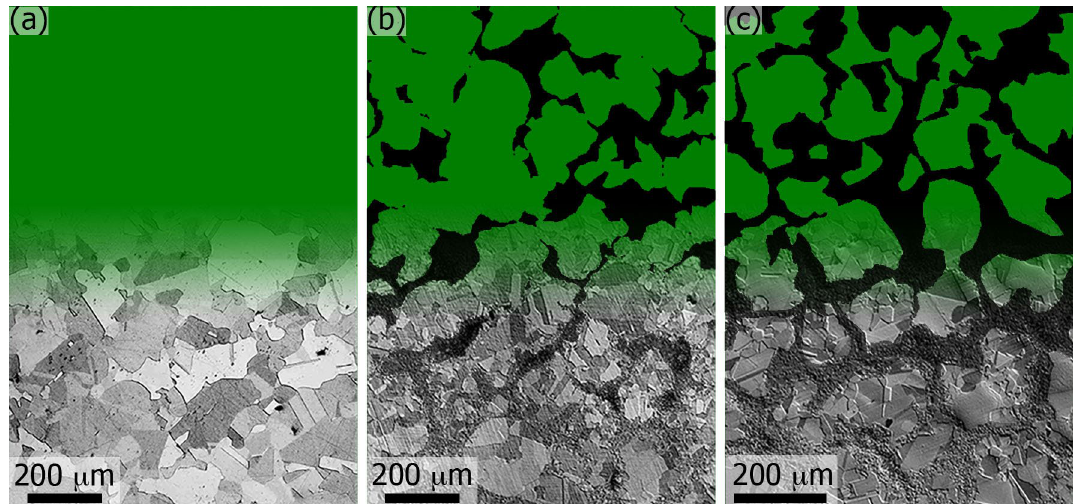
Figure 1. Representative optical micrographs of pure nickel with homogeneous CG ( a ) and heterogeneous bimodal random bR ( b ) and harmonic bHS (c) grain structures; the latter two ( b , c ) having a nominal UFG fraction of 40%. Actual (measured) fractions of UFG areas in ( b , c ) are f UFG = 34% and f UFG = 39%, respectively; mean diameters of coarse grains are d CG = 26.1 μm in ( a ), d CG = 20.4 μm in ( b ), and d CG = 21.0 μm in ( c ). The images have gradient transitions from real micrographs at the bottom to segmented areas at the top for CG (green) and UFG (dark-grey) core and shell, respectively. Note disconnected clusters of UFG grains in ( b ) versus virtually continuous UFG skeleton in ( c